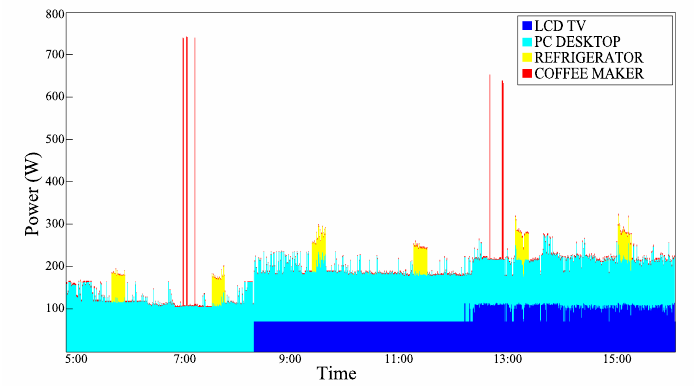
Figure 6. Aggregate power consumption trace—test case 1.